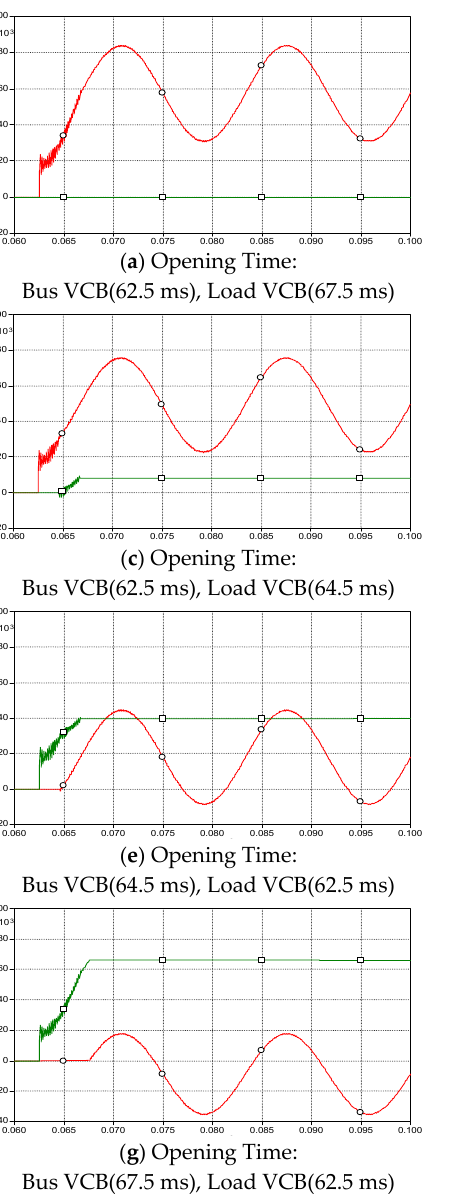
Figure 15. Simulation results of the transient recovery voltage for the proposed